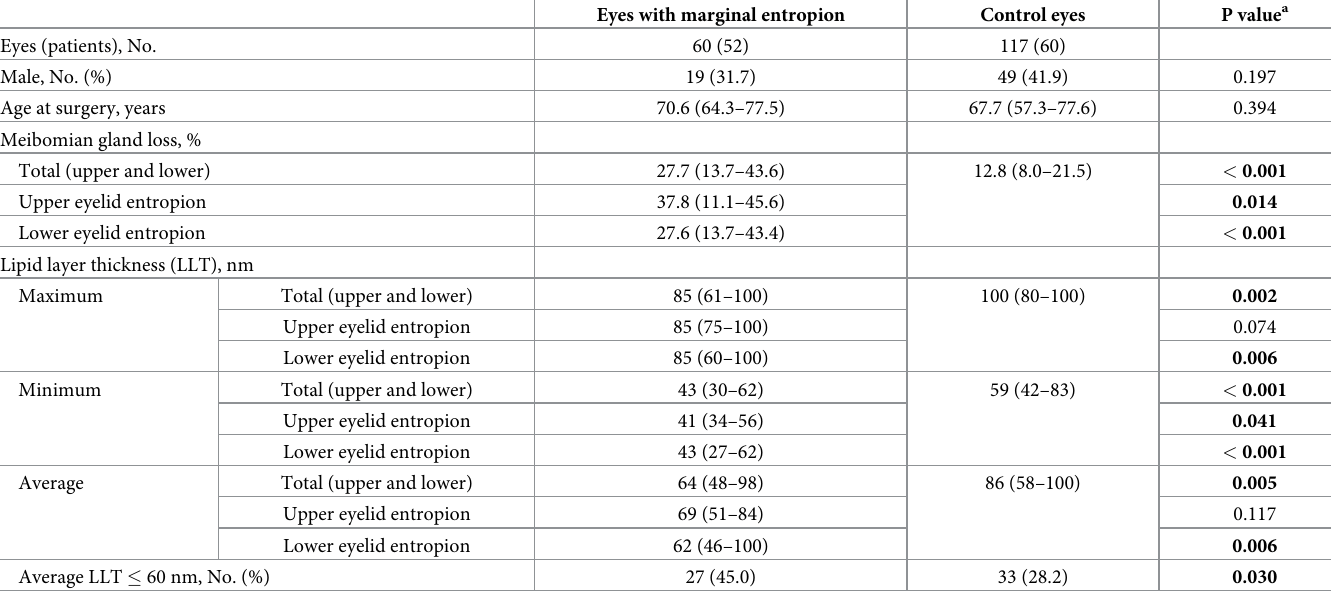
Table 1. Demographics, results of meibography and interferometer in eyes with marginal entropion and control eyes. Eyes with marginal entropion Control eyes P value